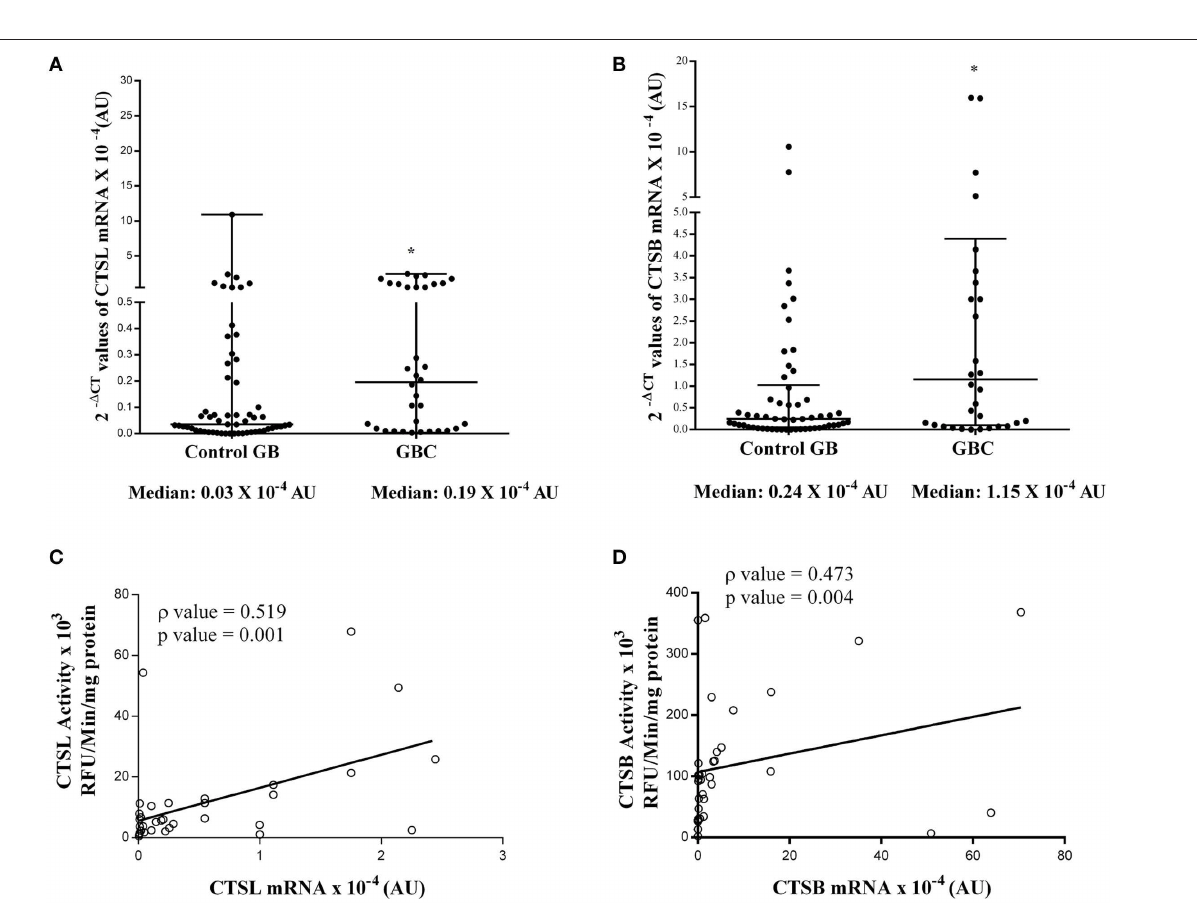
FIGURE 5 | Expression of cysteine cathepsin mRNA in GBC. Total cellular RNA isolated from gallbladder tissues obtained from controls ( n = 54) and GBC ( n = 34) patients were reverse transcribed and subjected to qRT-PCR using specific primers for (A) CTSL and (B) CTSB. After normalization with housekeeping gene 18S, 2 − 1 CT values were plotted and represented in a dot plot. Relative mRNA levels of these cathepsins were significantly elevated in GBC as compared to controls. Spearman Rank Correlation analysis between (C) CTSL activity and mRNA (D) CTSB activity and mRNA expression in GBC patients revealed transcriptional upregulation of these proteases in this malignancy. All values presented in the median with interquartile range (IQR). Results were analyzed using the Mann Whitney U test; * p ≤ 0.050 was considered statistically